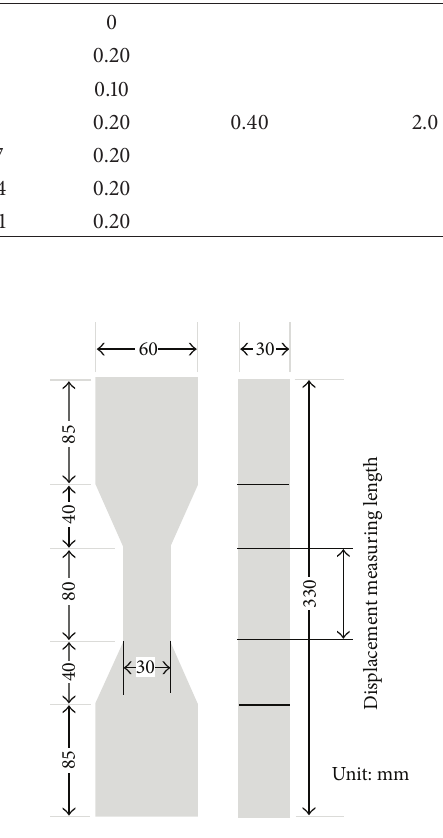
Figure 1: Details of specimen for direct tensile test (dog-bone